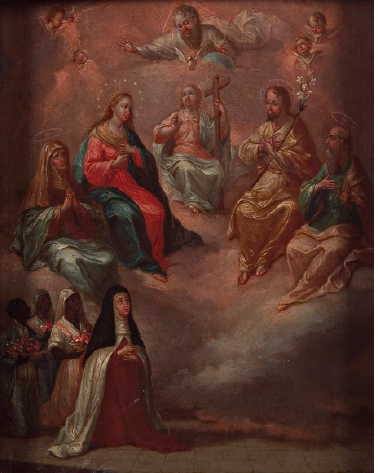
Figure 11. José Campeche y Jordán, Exvoto de la Sagrada Familia , oil on wood, 18th century. Colección Figure 11. Jos é Campeche y Jord á n, Exvoto de la Sagrada Familia , oil on wood, 18th century. Colecci ó n del Instituto de Cultura Puertorriqueña. del Instituto de Cultura Puertorriqueña.